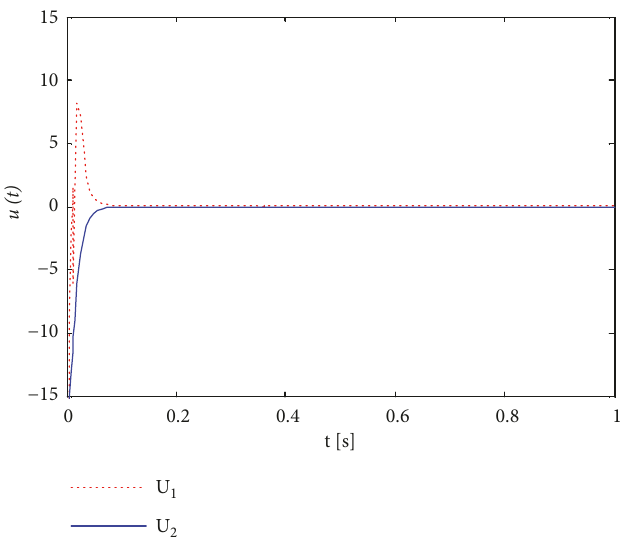
Figure 3: Control curve of memory state feedback controller.